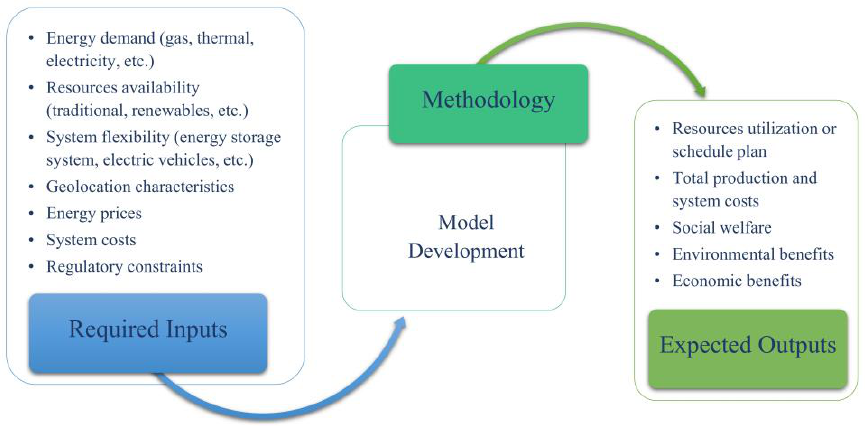
Figure 1. Schematic diagram of a generic energy system model [18 – 20].